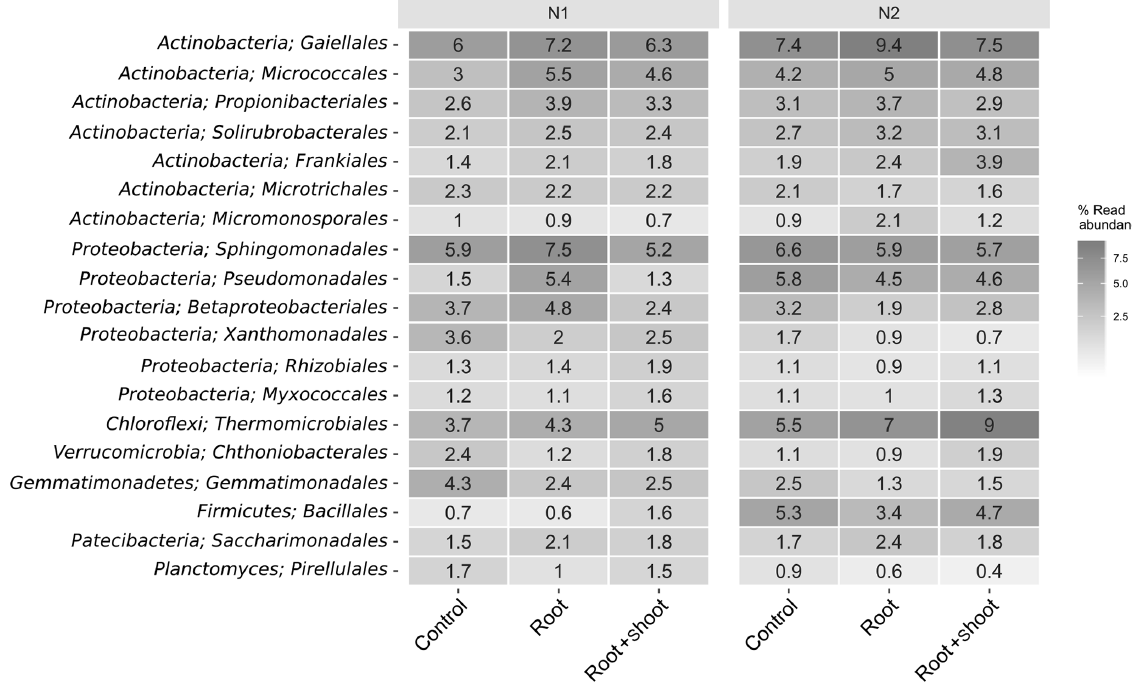
Figure 7. Heat map of the 16 most abundant bacterial orders of the soil-inhabiting bacterial community grouped by N levels and litter input ( n = 4, except for N2 root: n =